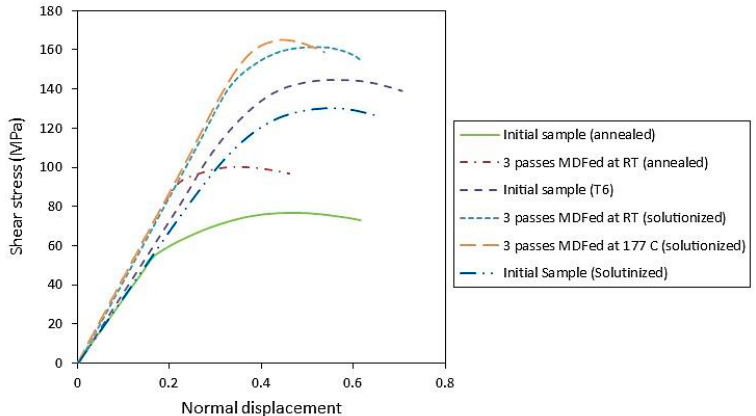
Figure 8. Shear stress versus normal displacement for annealed, solution ‐ treated, and T6 samples of AA ‐ 6063 alloy.